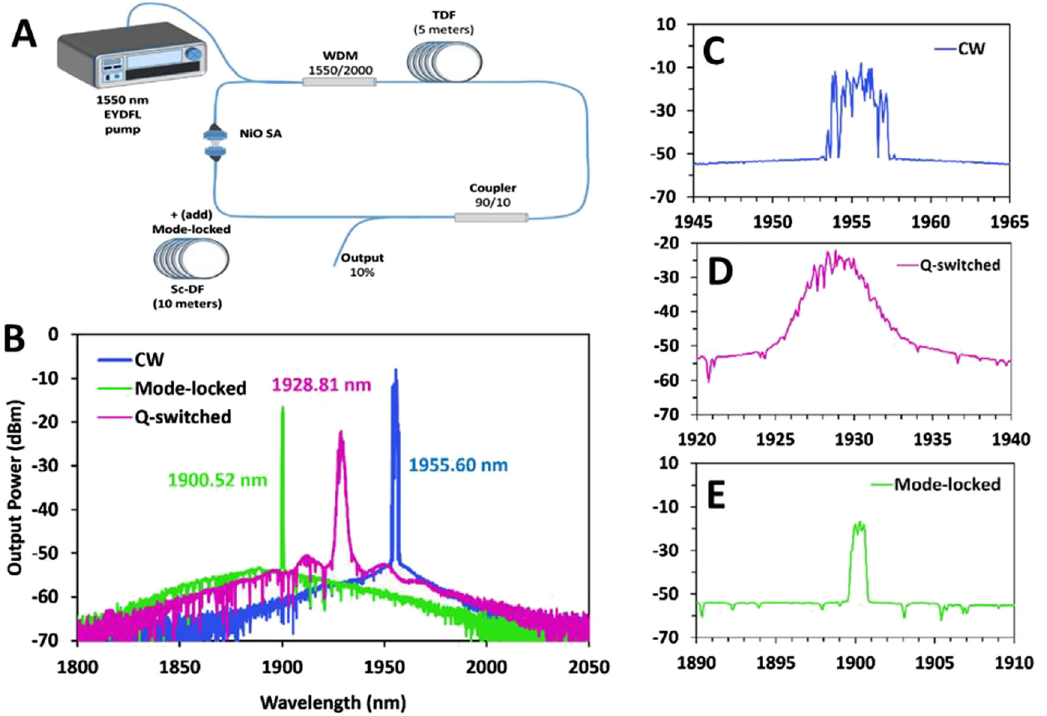
Figure 7: (A) Scheme of the thulium doped fiber laser. (B) Output spectra of the continues wave (CW), Q-switchedand mode locked fiber laser at the respective threshold pump powers. Each detailed spectrum is shown in (C), (D), and (E). Reprinted from Ref. [63] Copyright 2019, with permission from